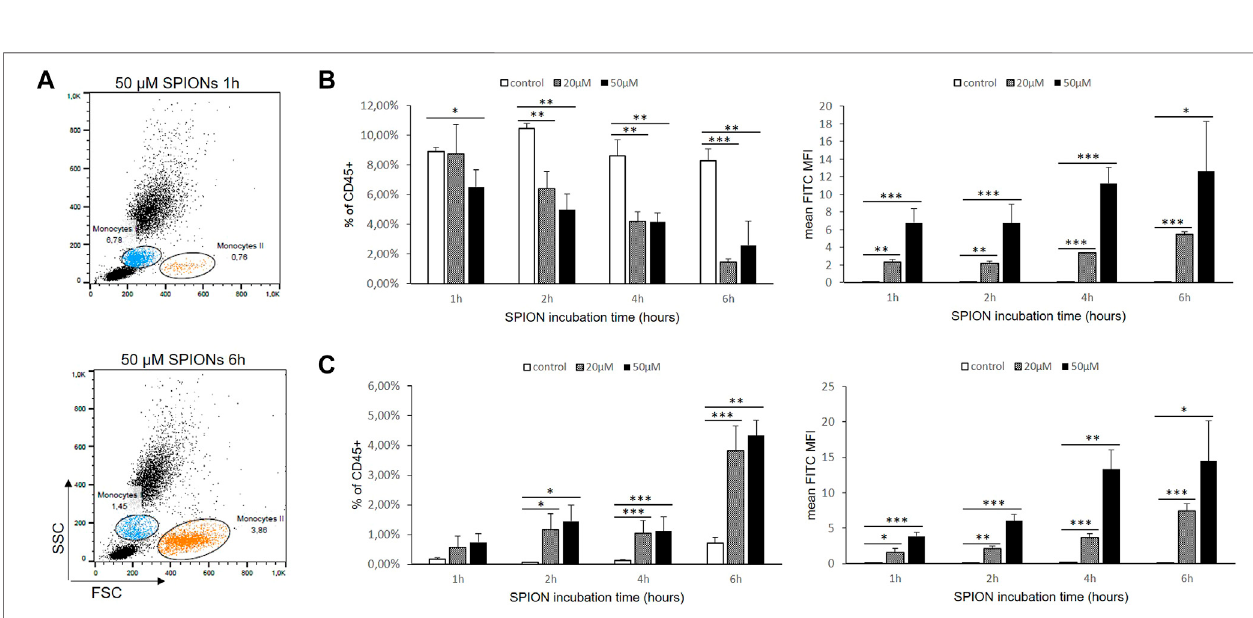
Frontiers in Molecular Biosciences |